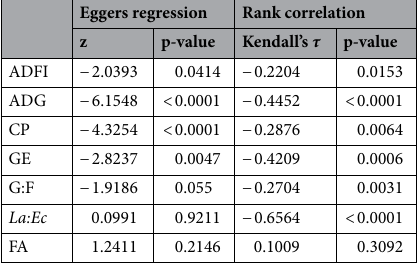
Table 6. Tests for publication bias.